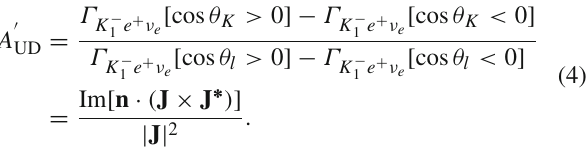
Experimentally, the semileptonic decay of D 0 → K 1 ( 1270 ) − e + ν e has been observed for the first time with a statistical significance greater than 10 σ by using 2.93 fb − 1 √ s = 3.773 GeV by BESIII [17]. of e + e − collision data at About 109 signals are observed, and the measured branching fraction is ( 1270 ) − e + ν ) = ( 1 . 09 ± 0 . 13 + 0 . 09 ± 0 . 12 ) B ( D 0 → K e 1 − 0 . 16 × 10 − 3